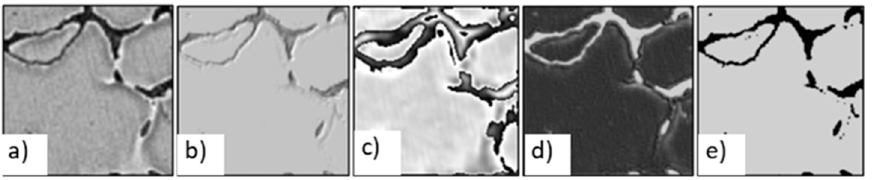
Figure 2. Results of the data augmentation processing for micrographs images. ( a ) Original micro- graphs, ( b ) micrograph images extracted from convolution layer 2, ( c ) extracted from convolution layer 4, ( d ) extracted from convolution layer 5, ( e ) final micrograph images in black and white.